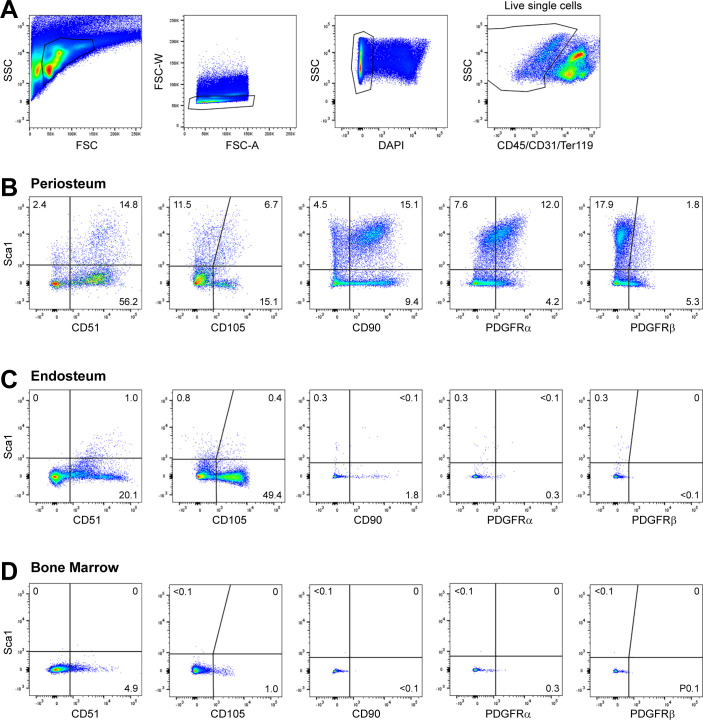
Flow cytometry plots of mesenchymal progenitor marker expression.Representative plots showing (A) the initial gating scheme to enable analysis of CD45/CD31/Ter119- mesenchymal cell populations in periosteum and expression of indicated markers in (B) periosteum, (C) endosteum, and (D) bone marrow of representative samples in relation to Sca1. Quadrant percentages are specific to the sample that is shown. The periosteum, endosteum, and bone marrow samples in each column come from the same sample (obtained from two animals). FSC, forward scatter; SSC, side scatter.